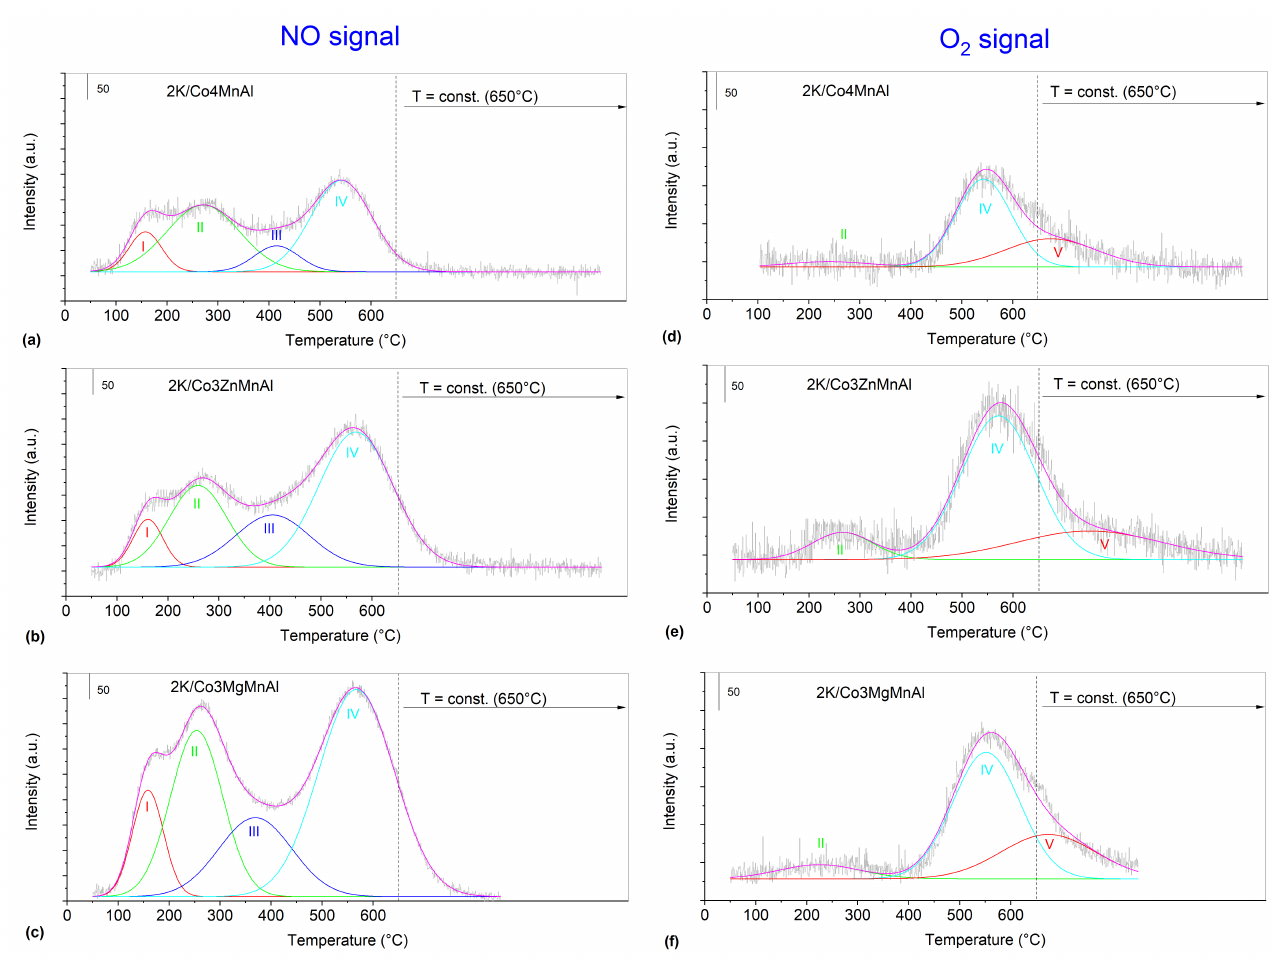
Figure 8. TPD-NO—deconvolution of NO signal for ( a ) 2K/Co4MnAl; ( b ) 2K/Co3ZnMnAl; and ( c ) 2K/Co3MgMnAl mixed oxide and O 2 signals for ( d ) 2K/Co4MnAl; ( e ) 2K/Co3ZnMnAl; and ( f ) 2K/Co3MgMnAl mixed